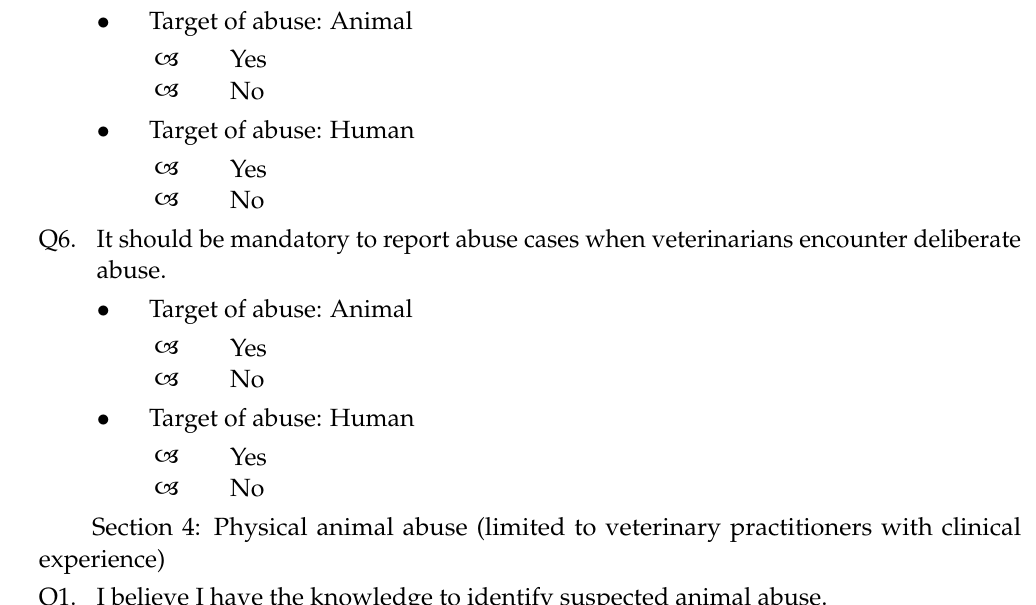
Section 4: Physical animal abuse (limited to veterinary practitioners with clinical ex- perience)